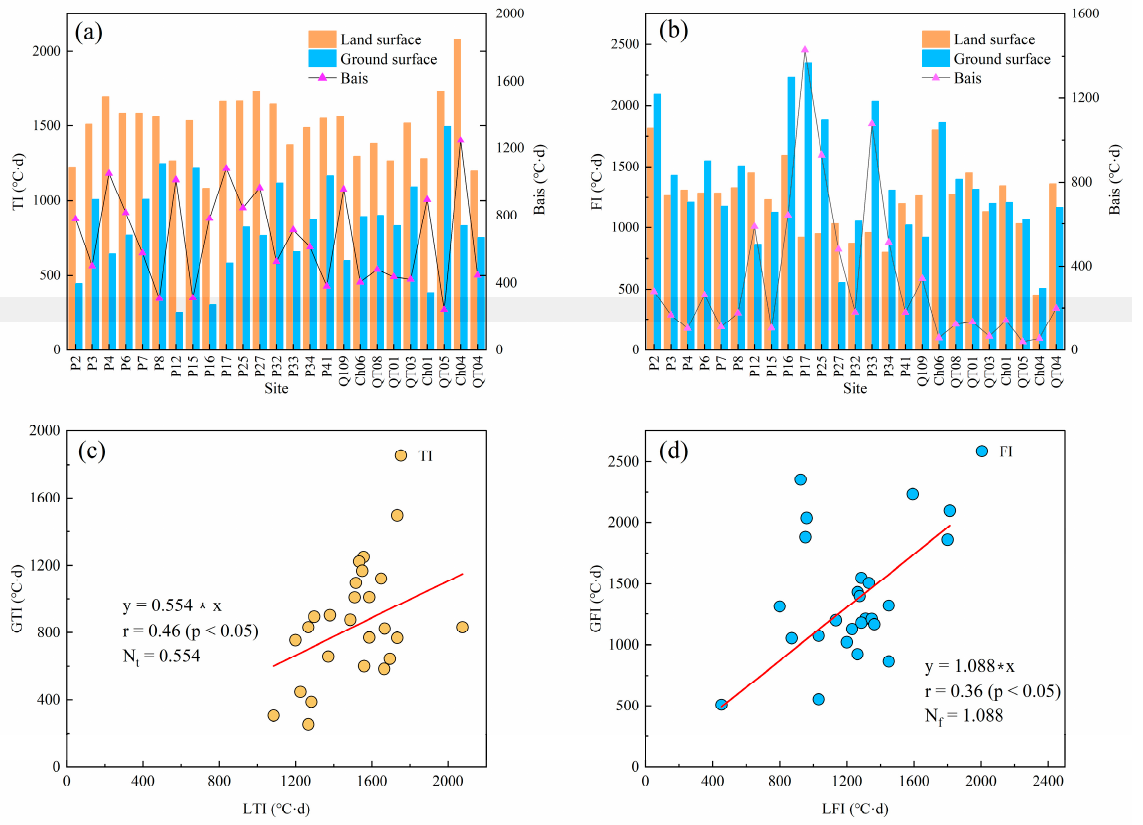
Figure 3. N-factors analysis between the GFI (or GTI) and the LFI (or LTI) at 25 field sites: ( a , c ) differences between the GFI with the LFI and N f , respectively; ( b , d ) differences between the GTI with the LTI and N t , respectively. The Pearson correlation coefficient (r) was used to evaluate the correlation between the variables in ( c ) and ( d ).